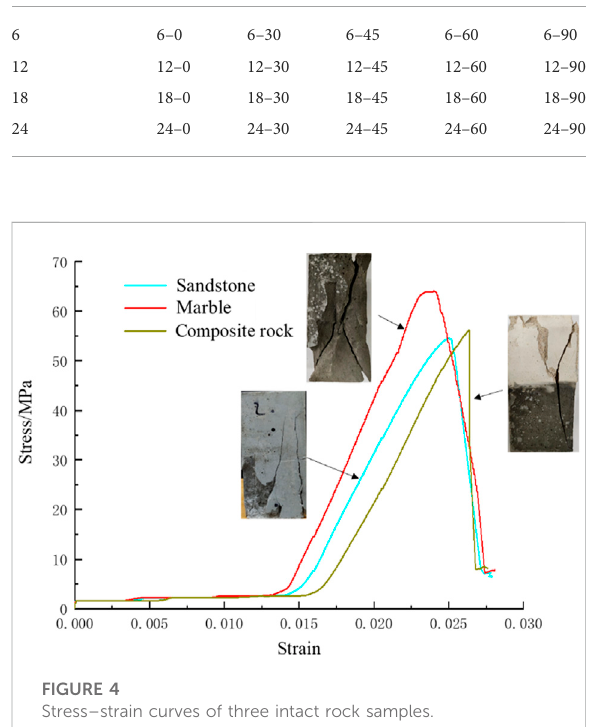
FIGURE 4 Stress – strain curves of three intact rock